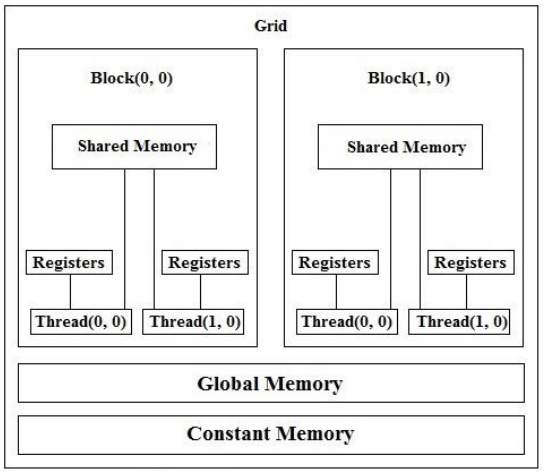
Figure 1. The Graphics Processing Unit (GPU) memory hierarchy [1].